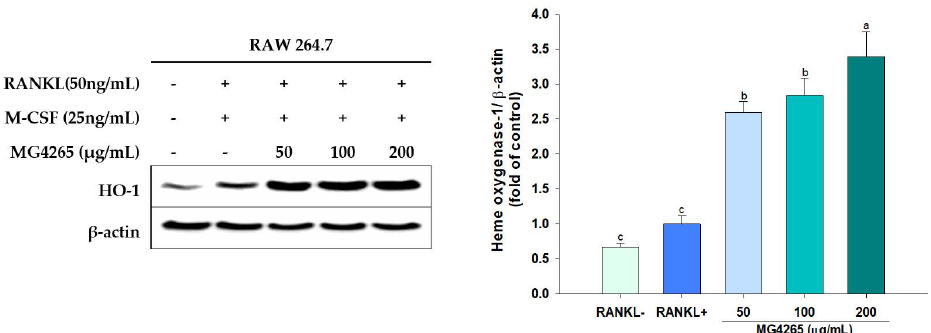
Figure 7. Effect of the SCS of L. salivarius MG4265 on HO-1 induction in RANKL-stimulated RAW 264.7 macrophages. Different letters (a–c) indicate significant difference at p <